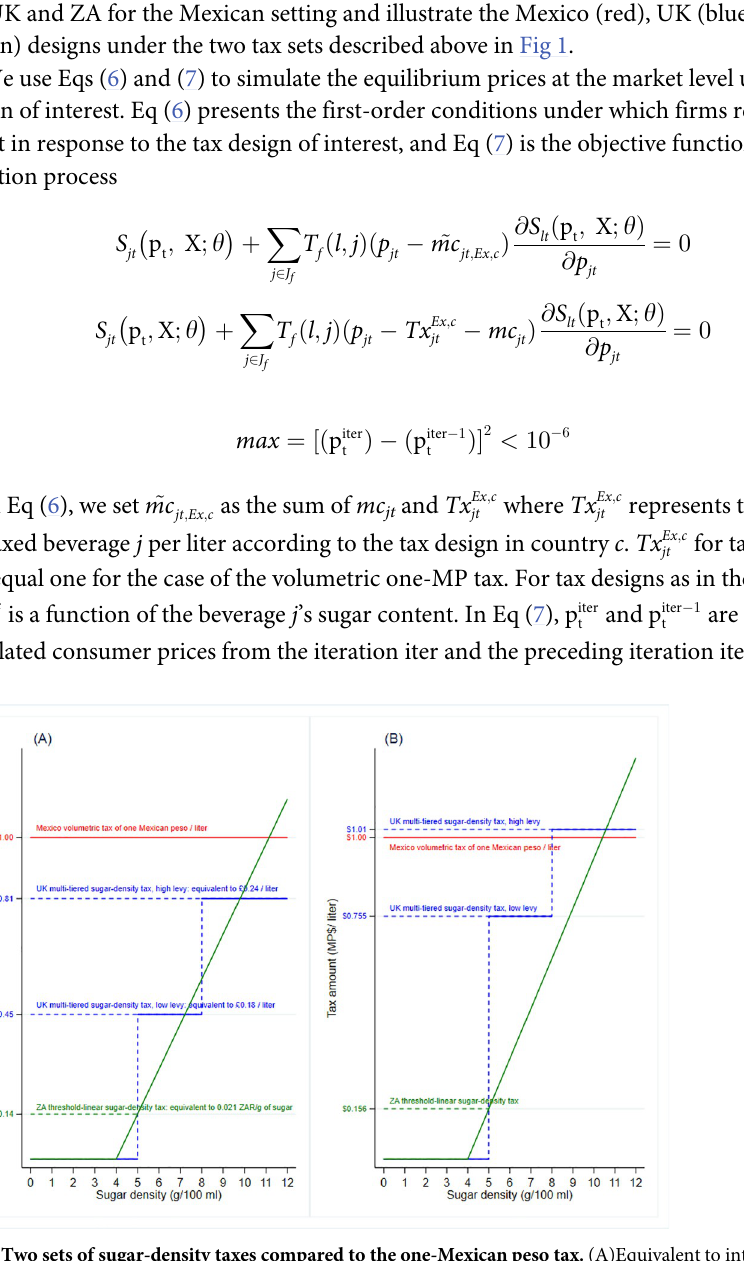
Fig 1. Two sets of sugar-density taxes compared to the one-Mexican peso tax. (A)Equivalent to international taxes (B) Equivalent to one-Mexican peso. UK: United Kingdom. ZA: South Africa. Source : Authors’ own analyses and calculations based on data from Nielsen through its Mexico Consumer Panel Service (CPS) for the food and beverage categories for January 2012 –December 2015. The Nielsen Company, 2016. Nielsen is not responsible for and had no role in preparing the results reported